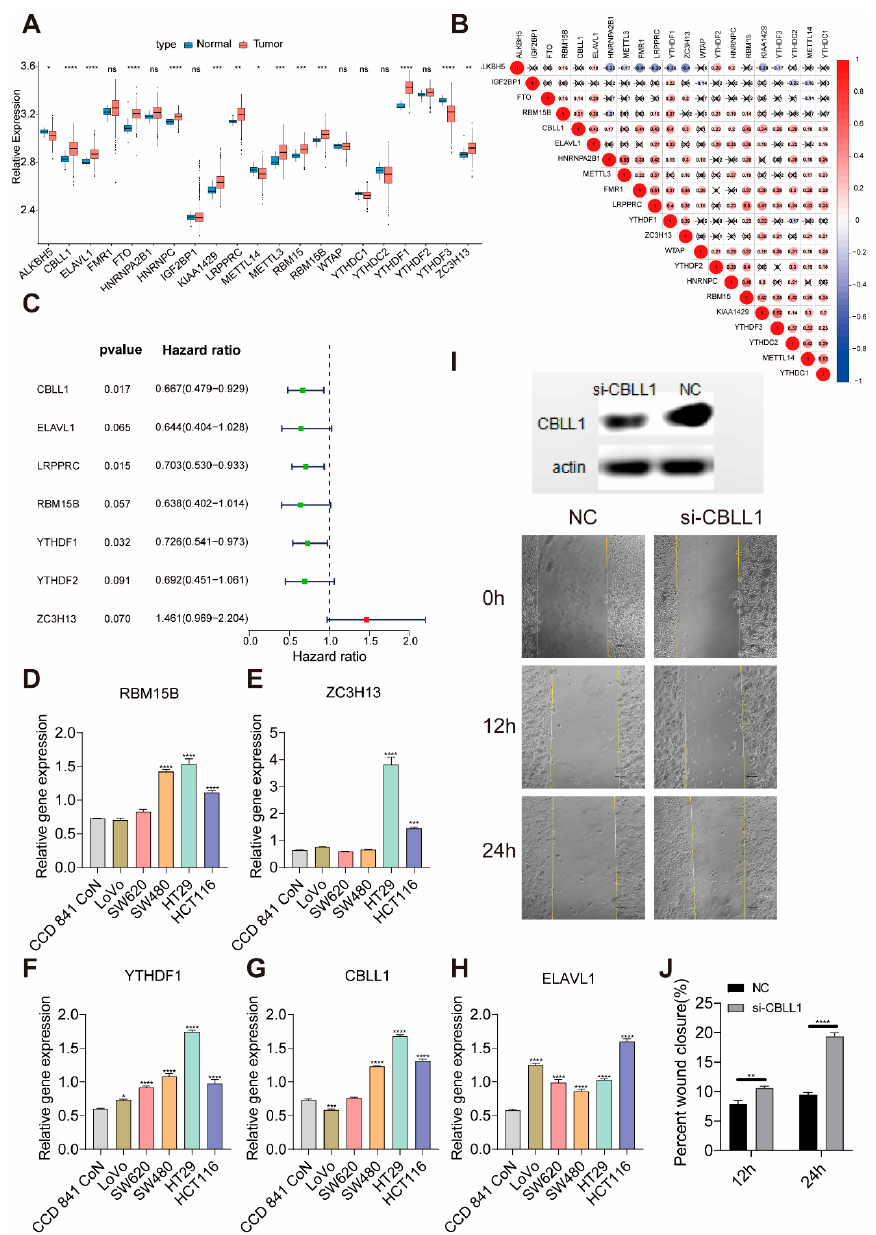
Figure 1. The expression of m6A regulators in colon cancer. ( A ) The expression of 21 m6A regulators between normal tissues and colon cancer tissues. Tumor, red; normal, blue. The upper and lower ends of the boxes represent the interquartile range of values. The lines in the boxes represent the median value, and the black dots show outliers. The asterisks represent the statistical p -value (* p < 0.05, ** p < 0.01, *** p < 0.001, **** p < 0.0001). ( B ) The interaction between m6A regulators in colon cancer. ( C ) The prognostic analysis for m6A regulators in colon cancer using a univariable Cox regression model. Hazard ratio >1 represents risk factors for survival and hazard ratio <1 represents protective factors for survival. ( D – H ) The expression of ELAVL1, RBM15B, ZC3H13, YTHDF1 and CBLL1 in different colon cell lines. ( I ) Western blot analysis of CBLL1 expression in HT29 cells treated for 72 h with CBLL1 siRNA(si-CBLL1) and negative control siRNA (NC), and knockdown CBLL1 promoted wound healing in HT29 cells (20 × magnification) by scratch analysis in 0, 12 and 24 h. ( J ) Monitoring of cell migration showed that silencing CBLL1 expression by siRNA promoted migration ability in HT29